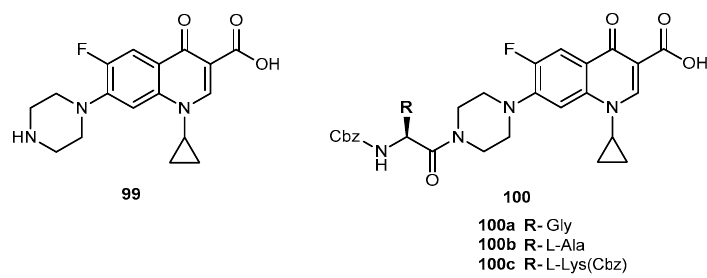
Figure 41. Structures of ciprofloxacin ( 99 ) and amino acid ciprofloxacin ( 100a – c) conjugates.